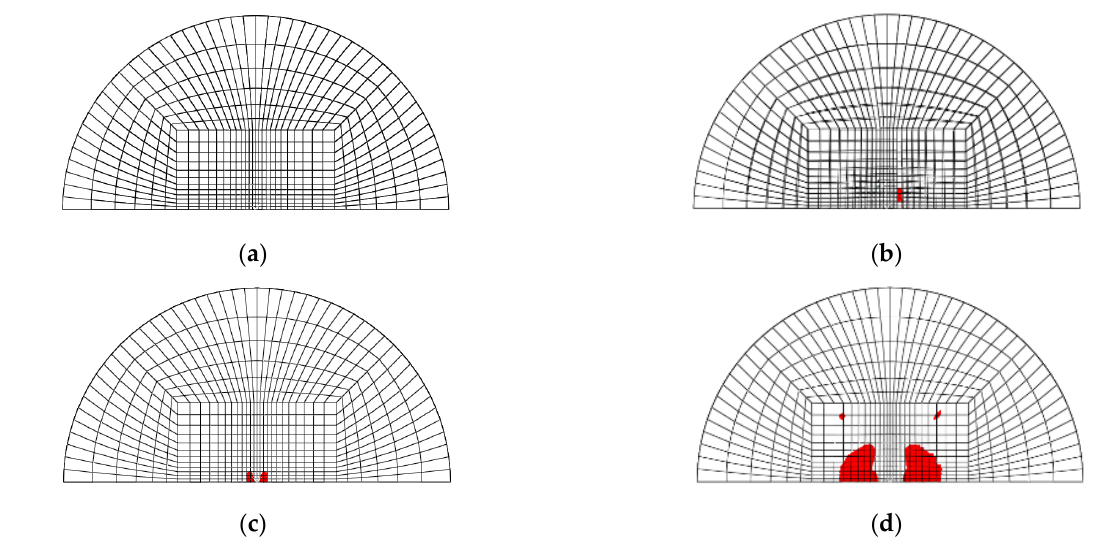
Figure 22. Fiber tension failure (FTF) in the composite layers of GLARE 5-2/1 with [0 ° /90 ° /90 ° /0 ° ] after applying the first impact energy of 16 J; ( a ) 2D failure model (0.392 ms), ( b ) 2D failure model (3.53 ms), ( c ) 3D failure model (0.392 ms), ( d ) 3D failure model (3.4 ms).